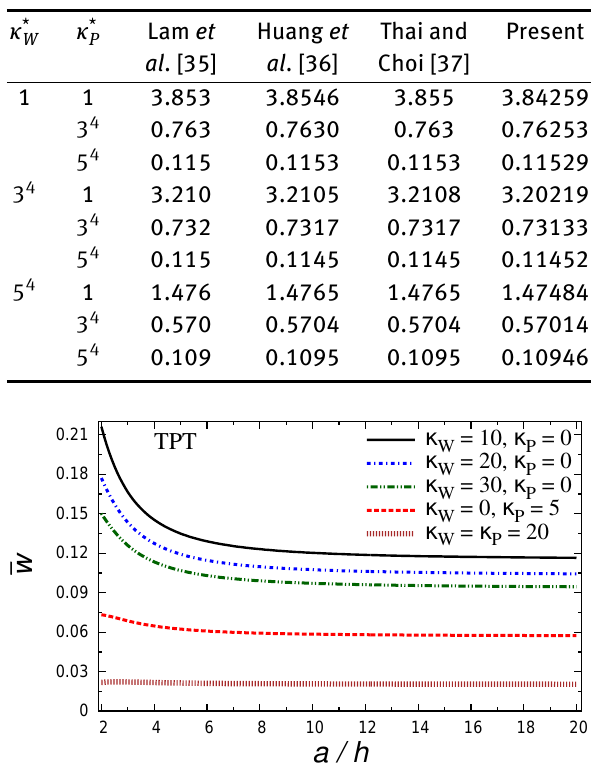
Table 1: Comparisons of central deflections neous square plate ( h = 0.01 a ) on Winkler-Pasternak foundations.